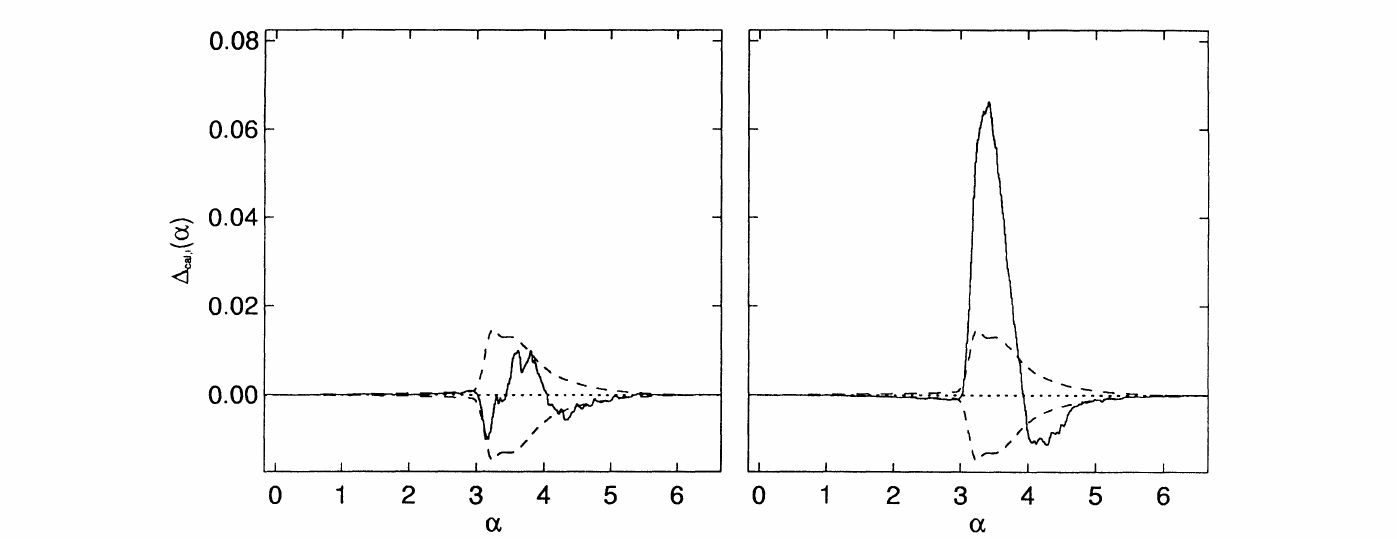
Distribution functions H(c) of scaling indices c. Left: Reference distribution function Hrer(c)= cl(C) as the empirical mean over 1320 calibration data sets of finite length T= 10000. Right: Distribution function Hcal,; of a single calibration data set. Notice the step-like behavior for c < 3 in both distribution functions.